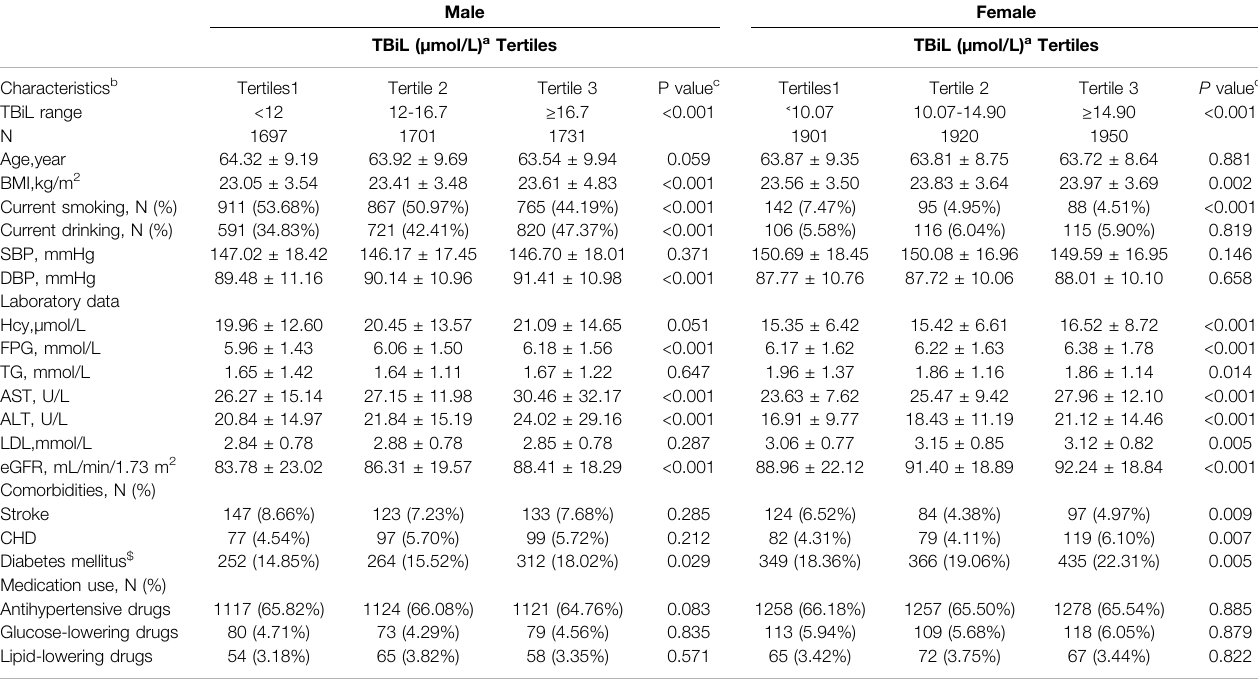
TABLE 1 | Baseline characteristics of study participants.